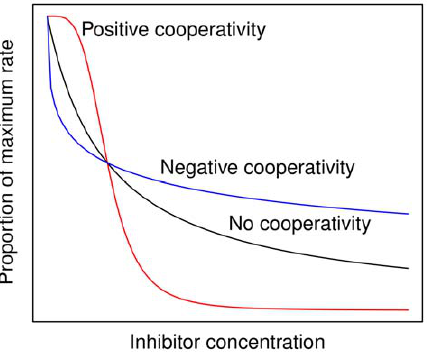
Figure 1. Positive and negative cooperativity in inhibitor binding an